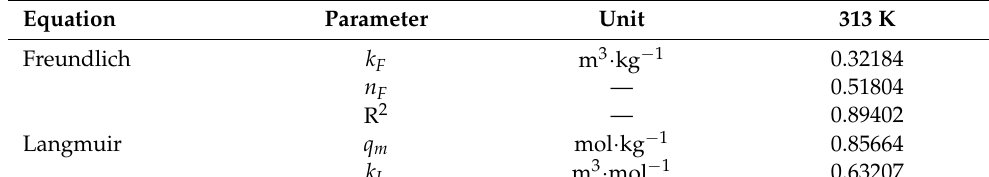
Table 8. Adsorption isotherm parameters for Pd(hfac) 2 from scCO 2 solution on SBA-15 at 8.5 MPa and 313 K [9].